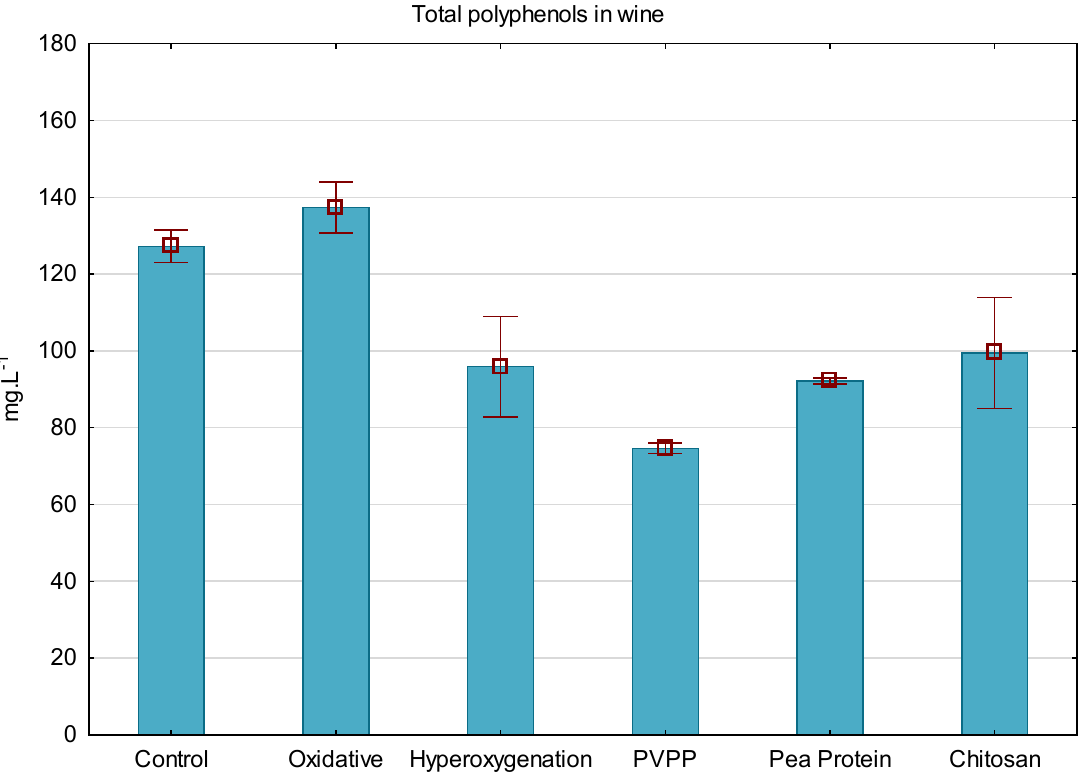
Figure 1. Concentration of total polyphenols in individual variants grape musts.